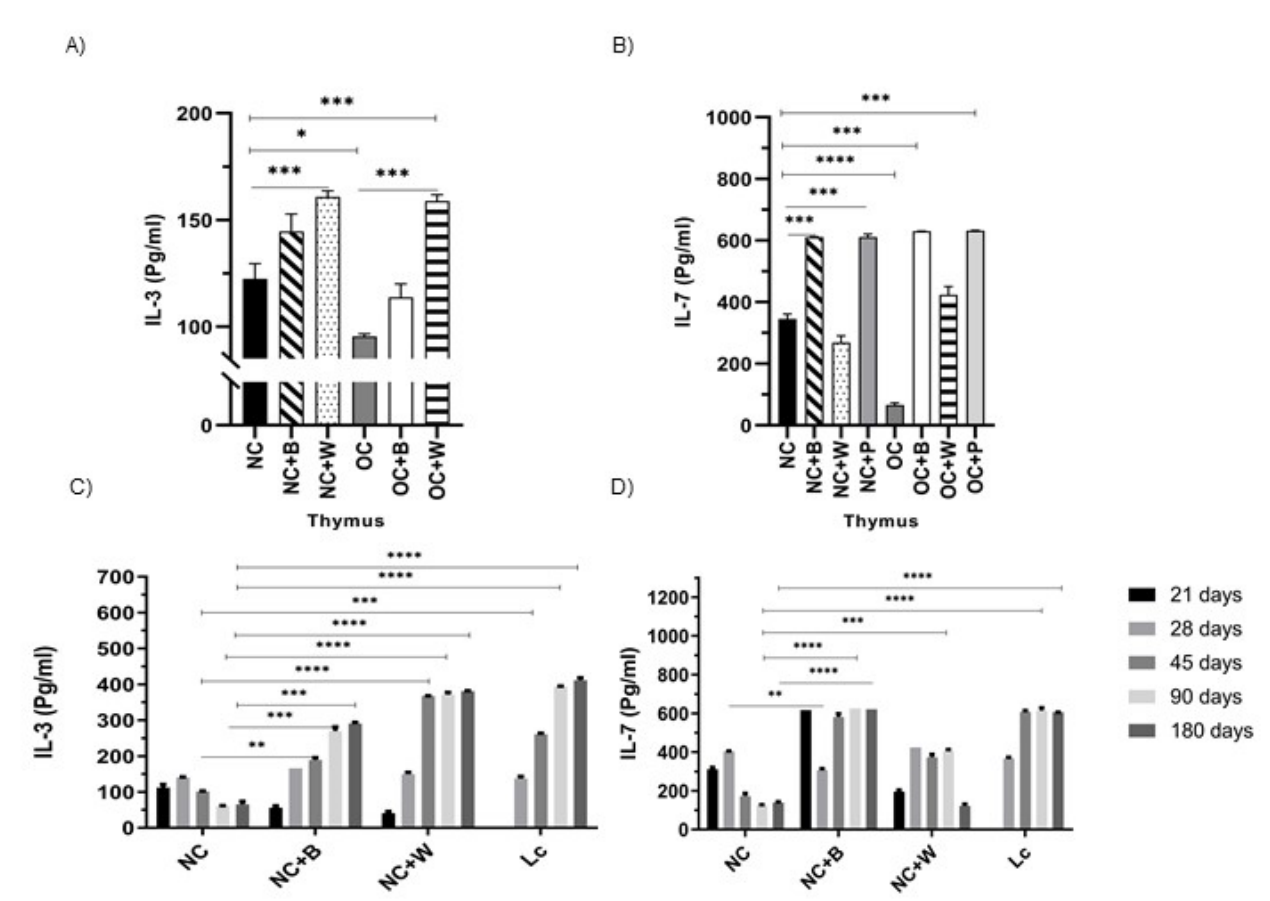
Figure 8. IL-3 and IL-7 levels in thymocytes from obese and old mice. The production of IL-3 ( A ) and IL-7 ( B ) of thymus cells was determined in the thymocyte culture supernatant from normal control (NC) and obese control (OC) mice. In senescent mice, IL-3 ( C ) and IL-7 ( D ) were determined in the thymocyte supernatant from mice at different ages (21, 28, 45, 90 and 180 days). The cell culture was stimulated by the probiotic bacterium (B) or its cell wall (W). Data were shown as mean ± SD of three independent experiments. One-way ANOVA with Tukey’s correction for multiple comparisons * p < 0.05; ** p < 0.01; *** p < 0.001; **** p < 0.0001.